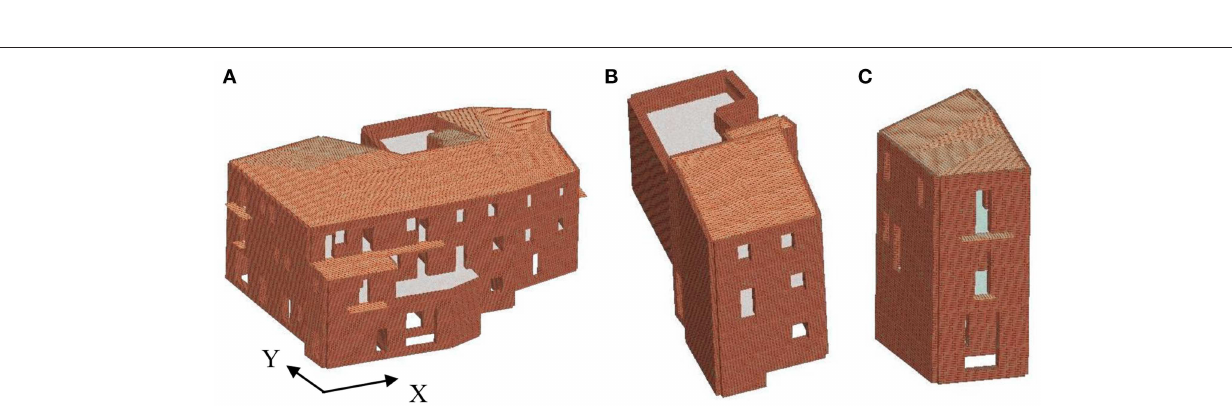
Frontiers in Built Environment | www.frontiersin.org